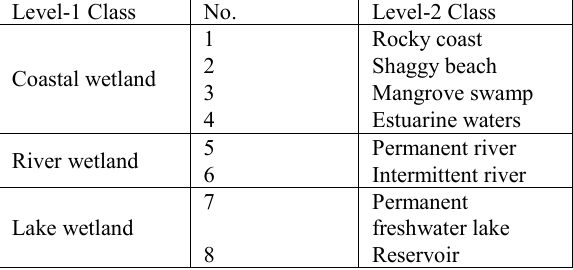
Table 1. Classification classes of wetlands in study